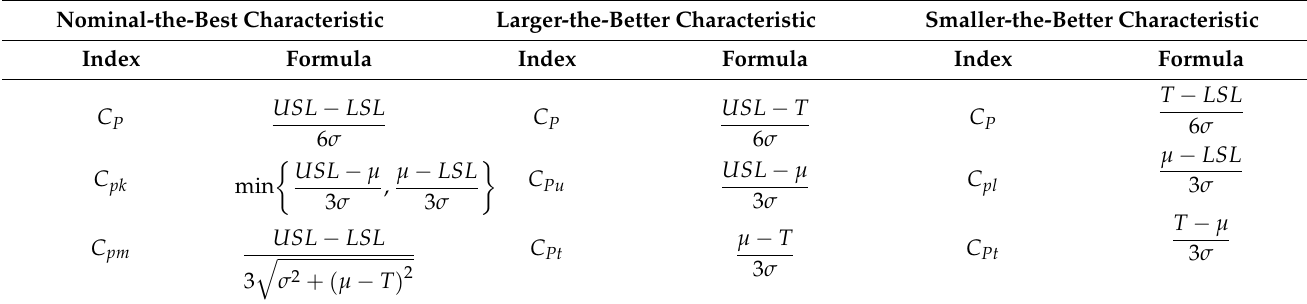
Table 1. Summary of process capability index of nominal-the-best, larger-the-better and smaller-the-better characteristics. Nominal-the-Best Characteristic Larger-the-Better Characteristic Smaller-the-Better